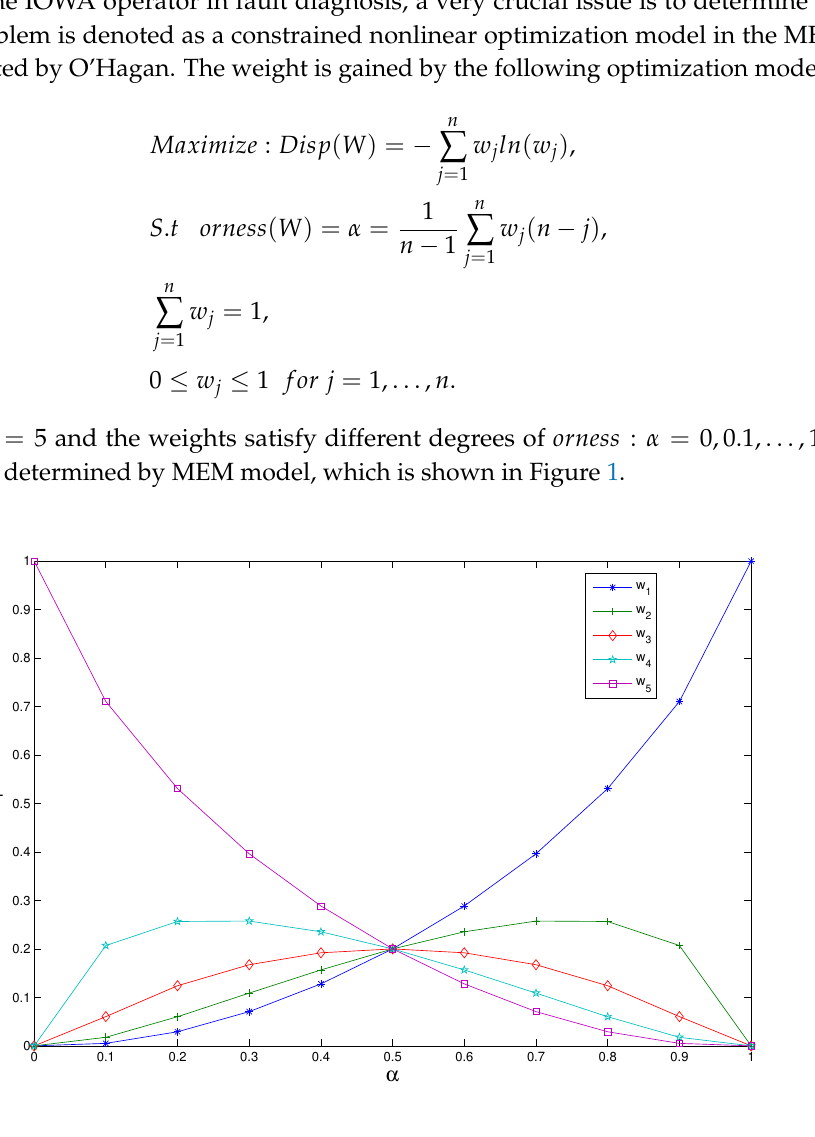
Figure 1. Variation of the weight with orness